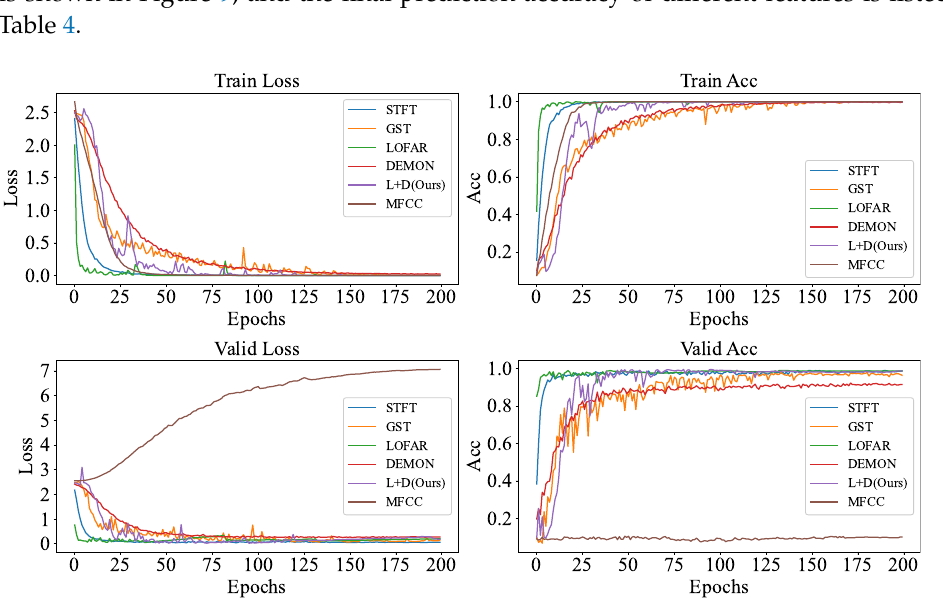
Figure 9. Training process with different features on simulation dataset for the F 0 estimation task, L+D is short for LOFAR+DEMON. The upper panel shows the loss and accuracy on the training dataset while the lower panel for validation